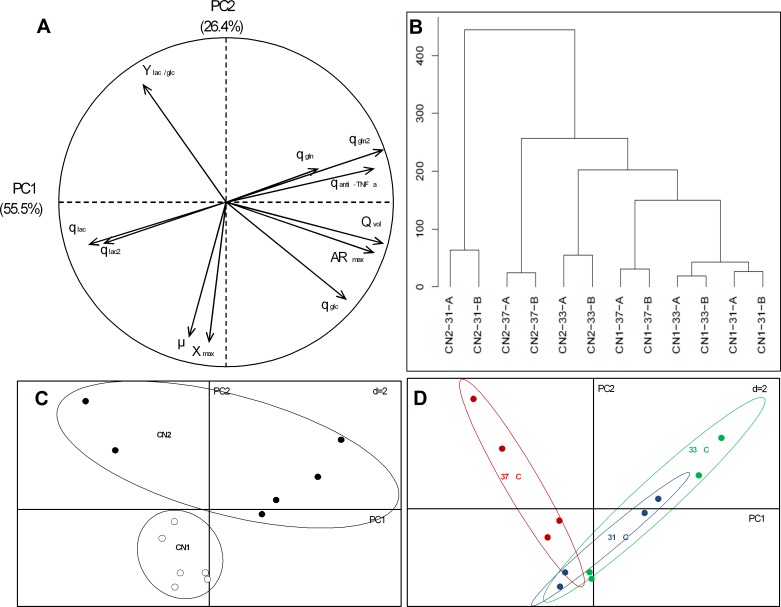
Principal component analysis (PCA) using 11 physiological parameters of CN1 and CN2 at 37, 33 and 31°C.The variables analysed were maximum cell density (Xmax), specific cell growth rate (μ), yield of lactate from glucose (Ylac/glc), specific anti-TNFα productivity (qanti-TNFα), maximum anti-TNFα production (anti-TNFαmax), volumetric productivity (Qvol), specific consumption rate of glucose (qglc), glutamine (qgln), and lactate after shift (qlac2); specific production rate of lactate (qlac) and glutamine after shift (qgln2). A: correlation circle showing relation between the measured parameters; B: Cluster analysis (Ward’s method) of the observations using Euclidian distance; C and D: Ordination of the first and second principal component (PC1 and PC2, respectively), showing observation distribution. Different conditions are plotted using circles to identify the effect of clones (C) and temperature (D).